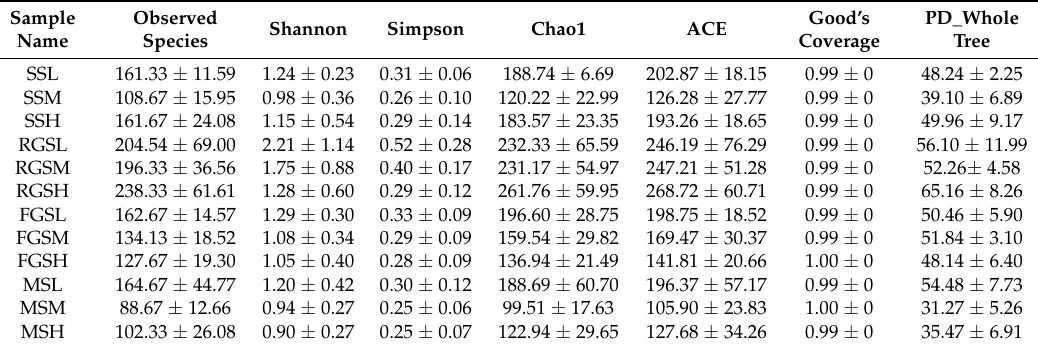
Figure 5. Rank abundance plots of fungal community composition in Nicotiana tabacum . Table 1. Median alpha diversity indices.